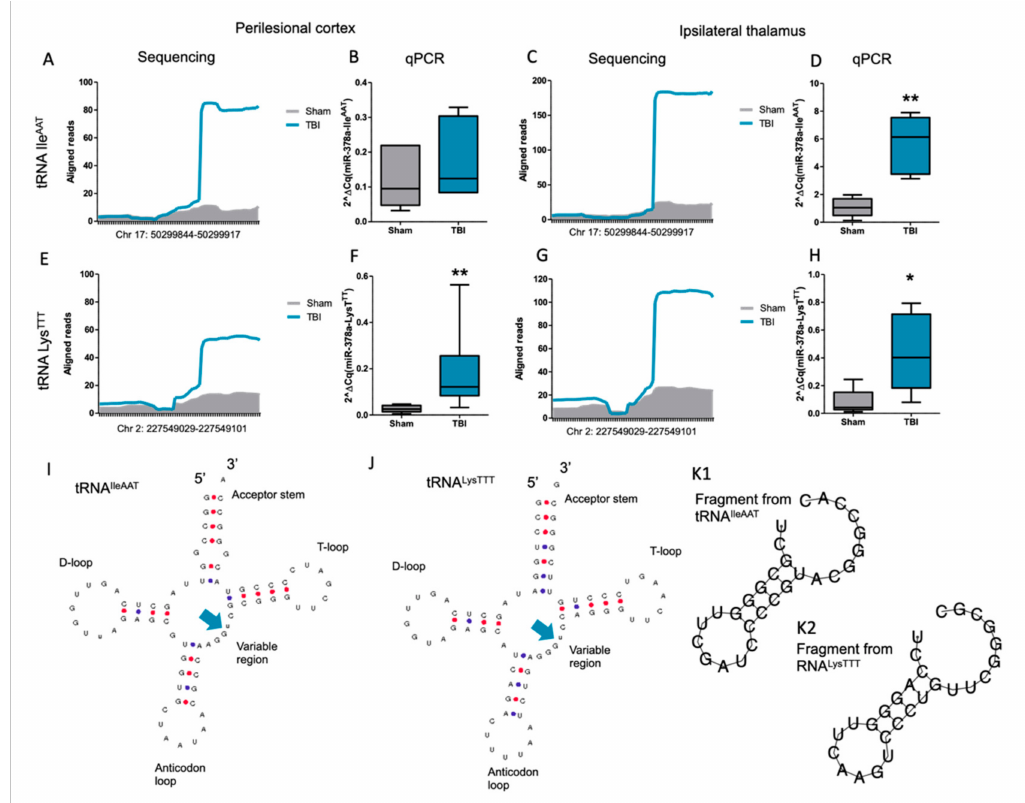
Figure 8. Transfer RNA fragments (tRFs) cleaved from tRNA IleAAT and tRNA LysTTT were upregulated in the perilesional cortex and ipsilateral thalamus after traumatic brain injury (TBI). ( A ) Alignment of the detected reads toward tRNA IleAAT in sham-operated controls (gray shading) and post-TBI rats (blue line) in the perilesional cortex samples. ( B ) Quantitative RT-PCR analysis showed a trend toward upregulation of 3 (cid:48) tRF-IleAAT (FC = 1.5, p > 0.05). ( C ) Alignment of the detected reads toward tRNAIleAAT in sham-operated controls (gray shading) and post-TBI rats (blue line) in the ipsilateral thalamus samples. ( D ) Quantitative RT-PCR analysis showed upregulation of 3 (cid:48) tRF-IleAAT (FC = 5.4, p < 0.01). ( E ) Alignment of the detected reads toward tRNA LysTTT in sham-operated controls (gray shading) and post-TBI rats (blue line) in the perilesional cortex samples. ( F ) Quantitative RT-PCR analysis showed upregulation of 3 (cid:48) tRF-LysTTT (FC = 6.9, p > 0.01). ( G ) Alignment of the detected reads toward tRNALysTTT in sham-operated controls (gray shading) and post-TBI rats (blue line) in the ipsilateral thalamus samples. ( H ) Quantitative RT-PCR analysis showed upregulation of 3 (cid:48) tRF-LysTTT (FC = 5.2, p < 0.05). ( I ) Most common cleavage site of fragments from tRNA IleAAT detected based on analysis presented in panels ( A and C ). ( J ) Most common cleavage site of fragments from tRNA LysTTT detected based on analysis presented in panels ( E and G ). ( K1,K2 ) Predicted RNA folding structure for 3 (cid:48) tRFs upregulated after TBI. Statistical significance: *, p < 0.05; **, p <